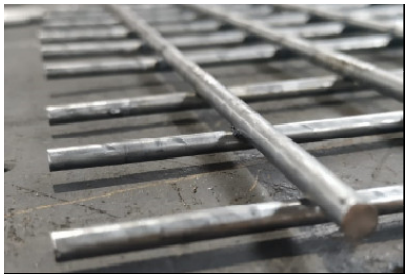
Figure 1. Two perpendicular wires welded by the CWW process that represents one group of prod- ucts.